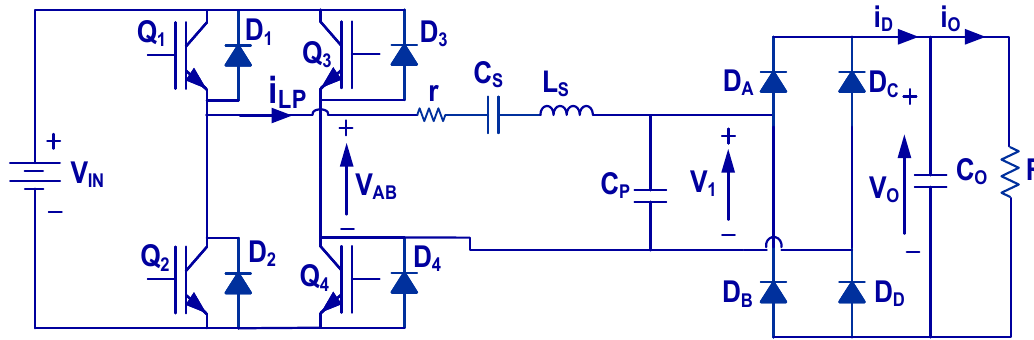
Figure 10. Experimental converter used to obtain the Bode diagram and the corresponding waveforms. The transformer has been replaced by discrete L S and C P parts.